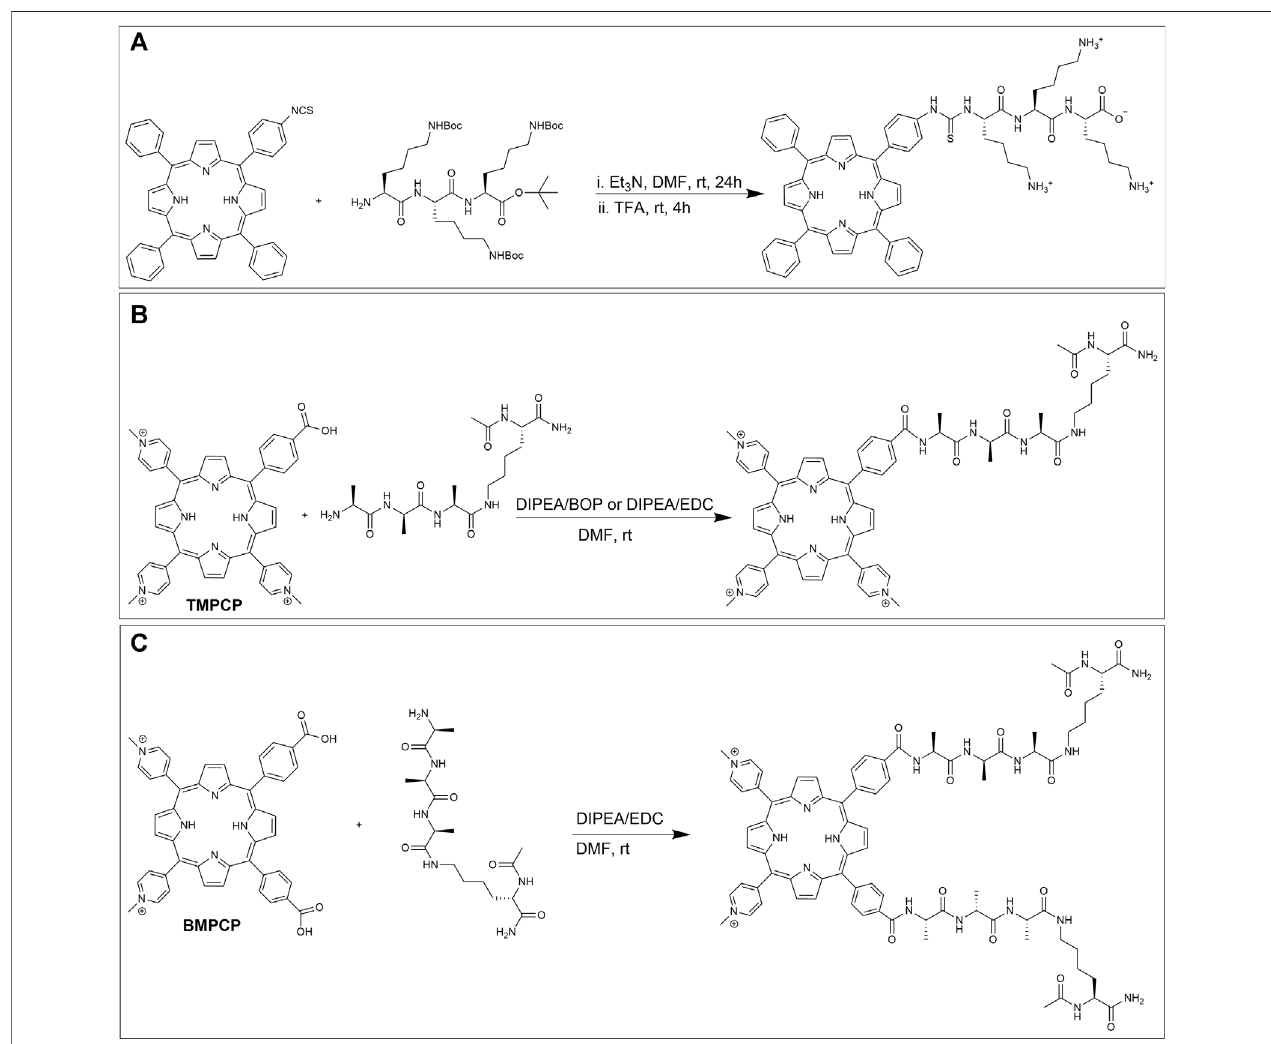
FIGURE 10 | (A) Conjugation scheme for a mono-isothiocyanate functionalized porphyrin and Bocprotected poly-L-lysine and subsequent deprotection (Sibrian- Vazquez et al., 2005). (B) Reaction of TMPCP and one tetrapeptide. (C) Reaction of BMPCP and two tetrapeptides by amide linkage formation (Mez ő et al., 2011).